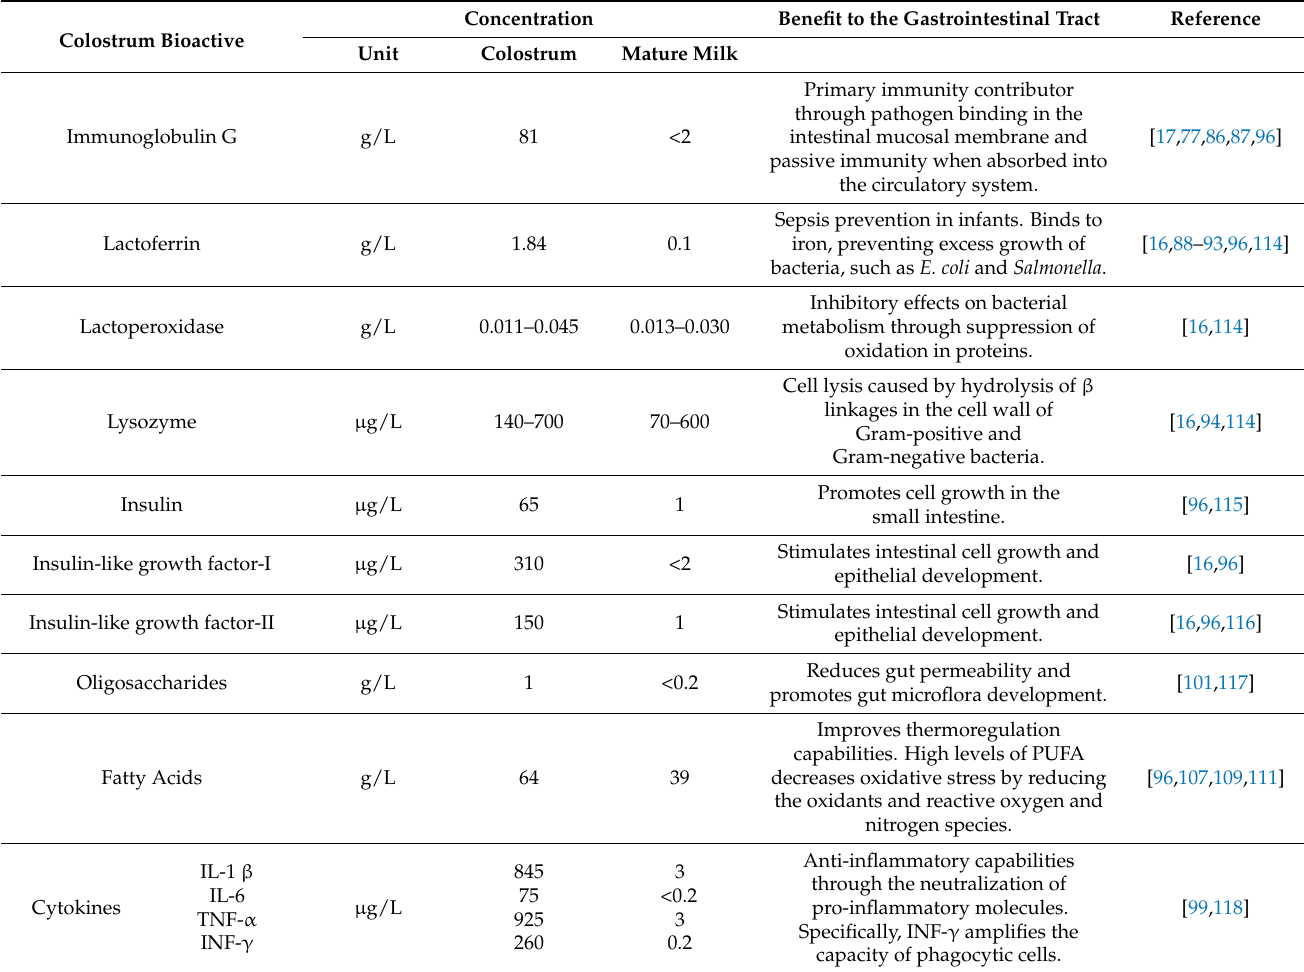
Table 1. Benefits to gut immunity and development provided by colostrum